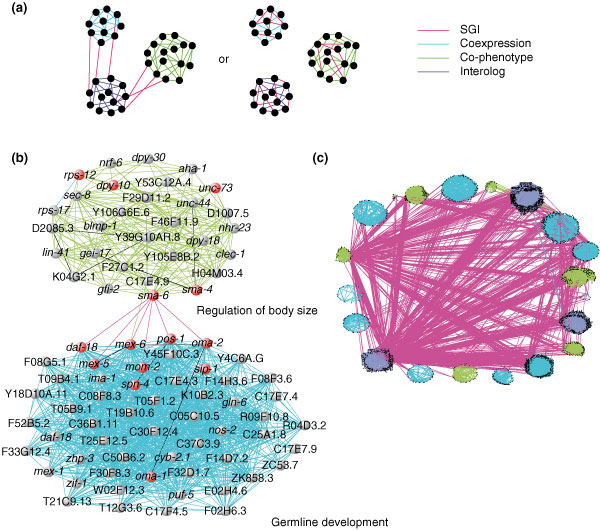
SGI interactions bridge subnetworks. (a) Three hypothetical subnetworks are depicted. We asked whether SGI interactions are more likely to bridge subnetworks (left) or fall within subnetworks (right). (b) An example of a bridged subnetwork pair is shown. A 'regulation of body size' co-phenotype subnetwork (green links) is linked to a 'formation of primary germline' coexpression subnetwork (blue links) via six SGI interactions (pink links). Visualization generated with Visant [86]. (c) Broad subnetworks were identified separately within the coexpression (blue), co-phenotype (green), and interolog (purple) networks (see Materials and methods). All broad subnetworks that are significantly bridged with at least one other broad subnetwork by SGI interactions (pink edges) are shown. Nodes (black dots) represent individual genes. Visualization generated with Visant [86].